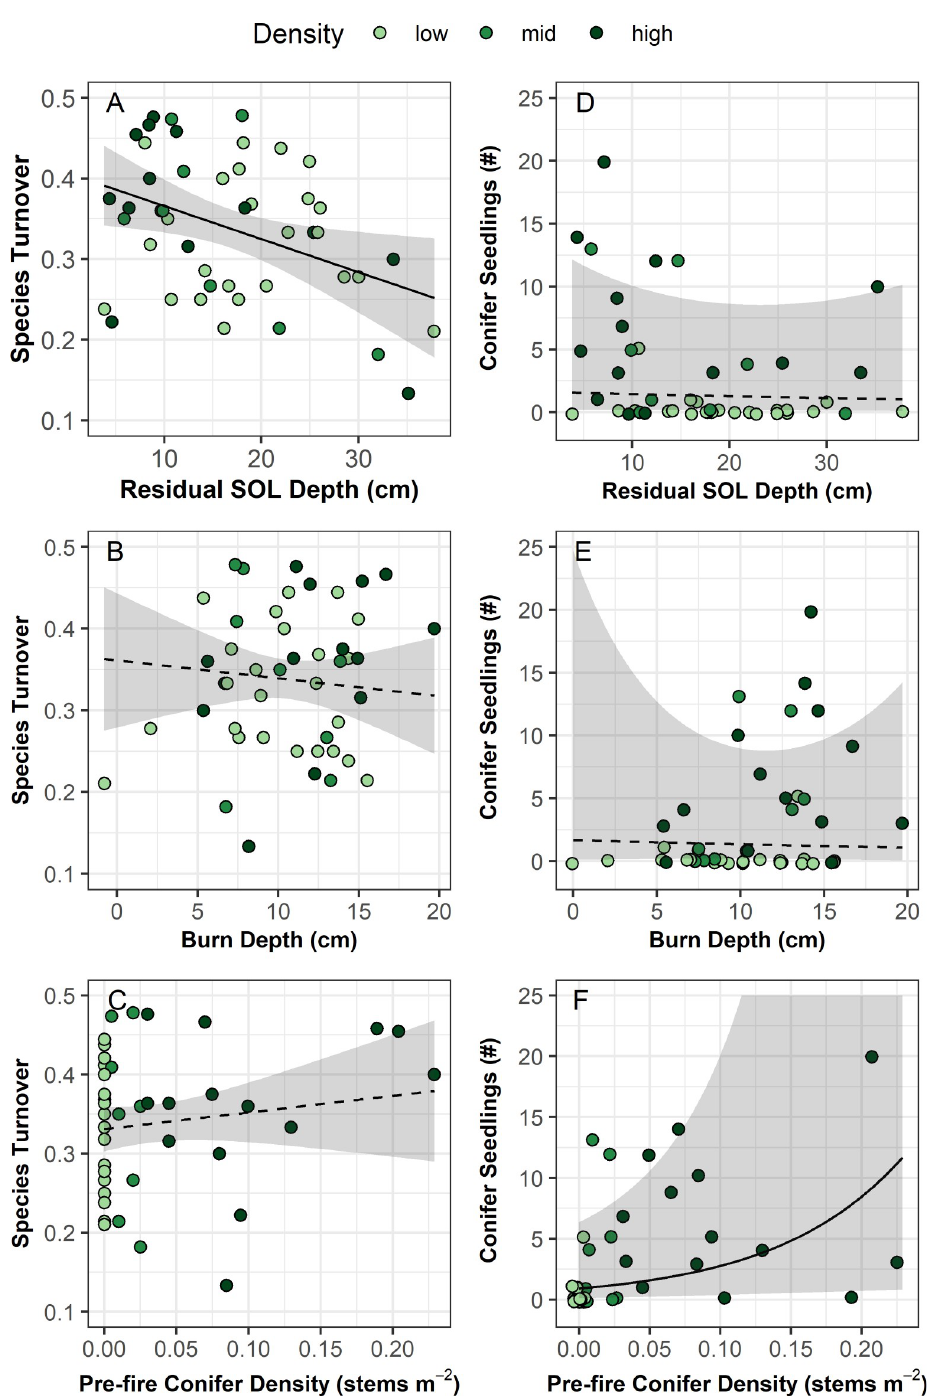
Fig 8. Species turnover index and conifer seedling counts as a function of residual soil organic layer (SOL) depth, burn depth, and pre-fire conifer density. Black lines represent modelled relationships (solid = significant at p-value 0.05, dashed = not significant) and shading represents 95% confidence regions. Species turnover was modelled with a linear mixed effect model and conifer seedling count was modelled with a generalized linear mixed effect model fit with a type II negative binomial distribution. Both models included a random effect of grid (2 levels). See Table 2 for model results.